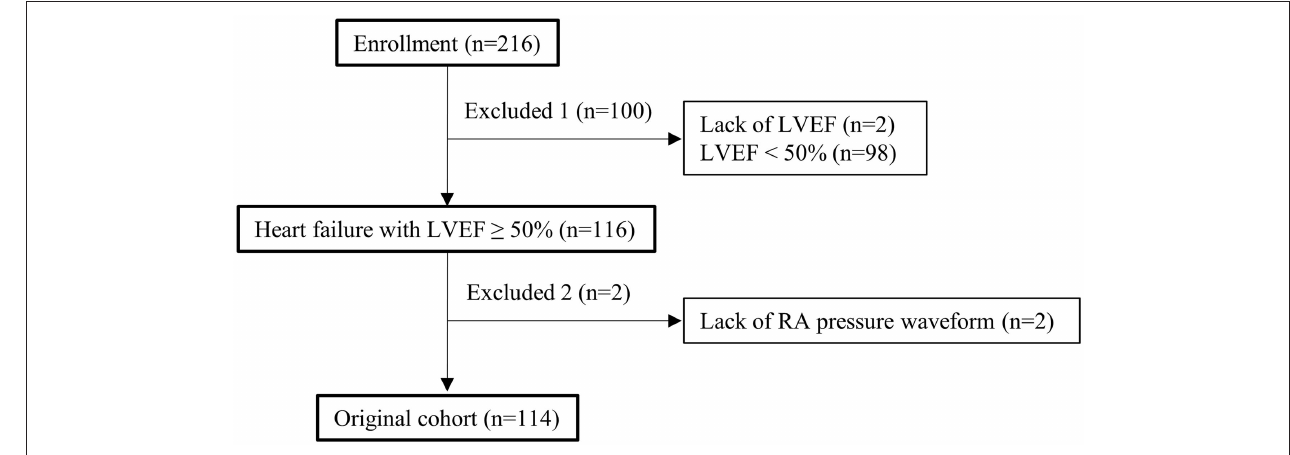
FIGURE 1 | Study flowchart. LVEF, left ventricular ejection fraction; RA, right atrial.